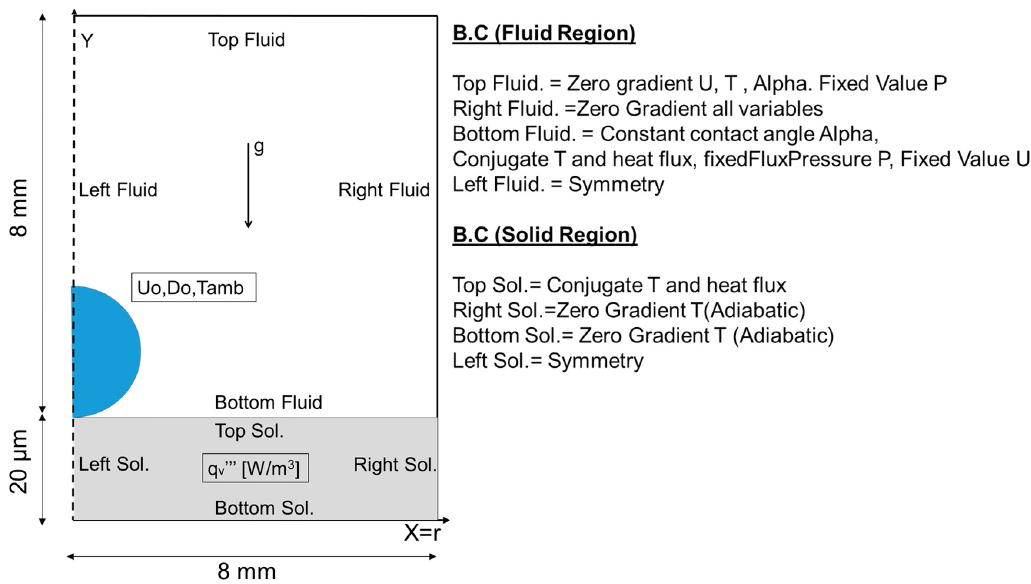
Figure 4. Schematic view of the computational domain, boundary conditions and initial condition for the simulations.